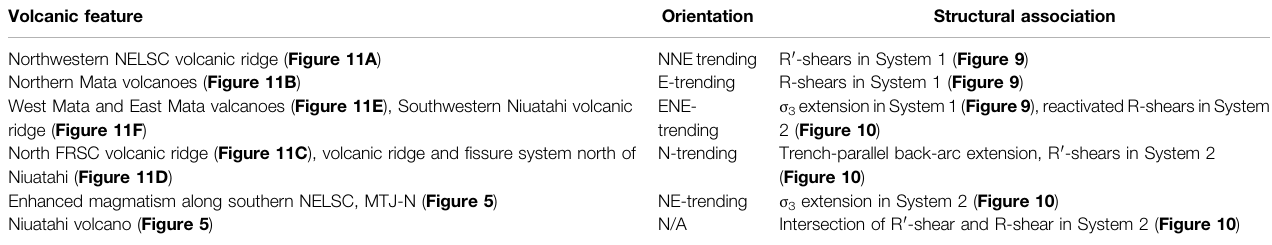
TABLE 2 | Volcanic features associated with enhanced magmatism in the map area and structural association in relation to Riedel Systems 1 and 2 ( Figures 9 , 10 ). Volcanic